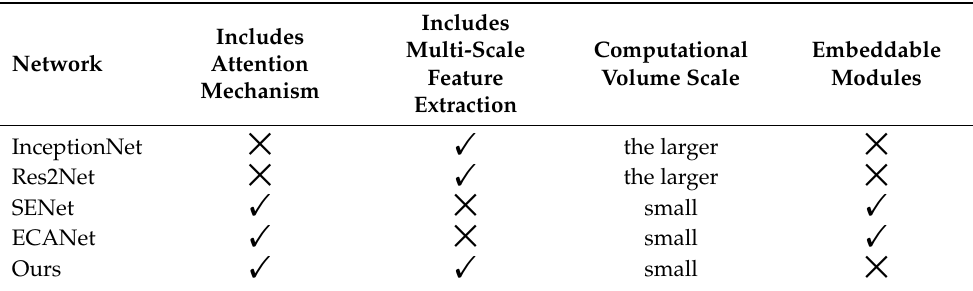
Table 1. The similarities and differences between our work and related multi-scale feature extraction methods and attention mechanisms.